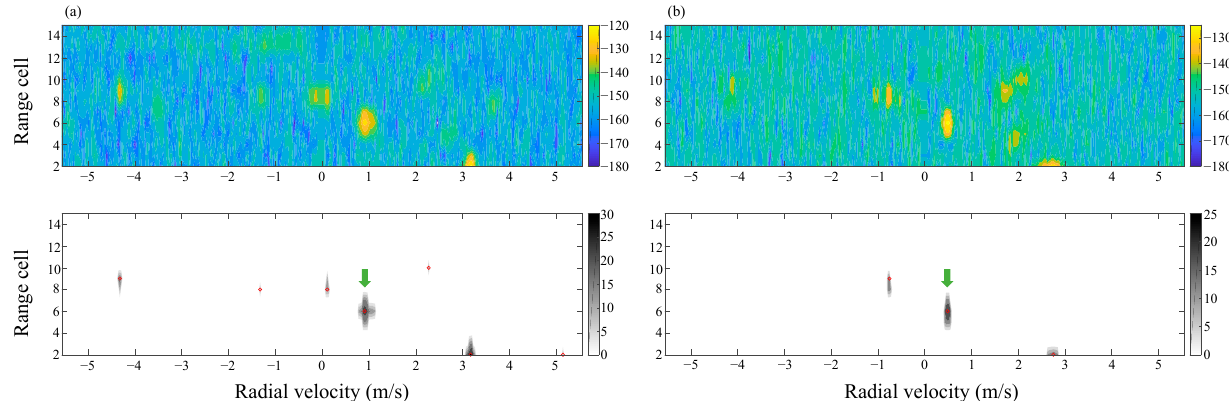
Figure 9. Two consecutive detection results using the ASI algorithm; the green arrows are radar signals of ship 1: ( a ) At 7:59 on 29 October 2013 (UTC); ( b ) At 8:16 on 29 October 2013 (UTC).